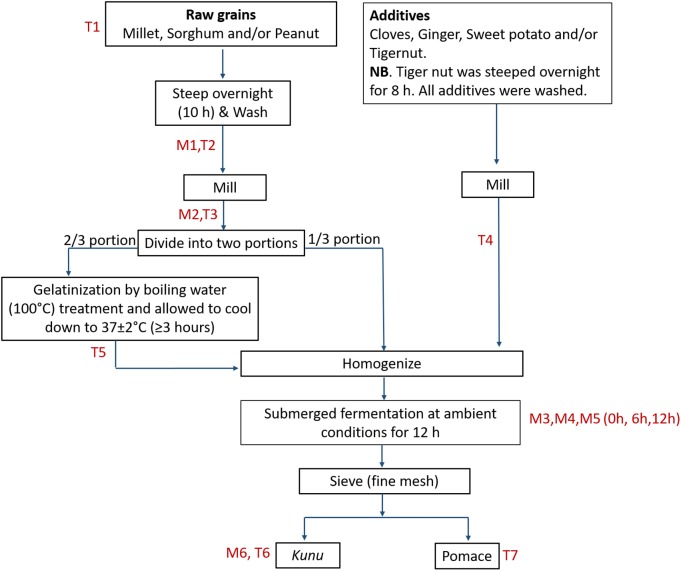
Flow for kunu processing. M and T represent points of sample collection for bacterial community and mycotoxin analyses, respectively.